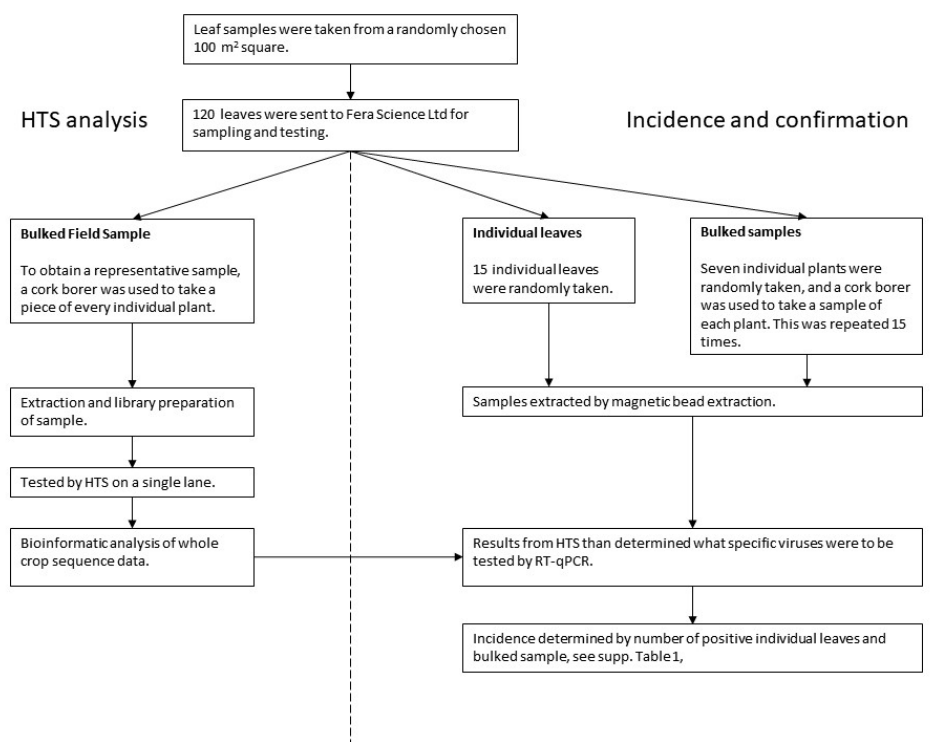
Figure 3. Pea sampling and testing flow chart.